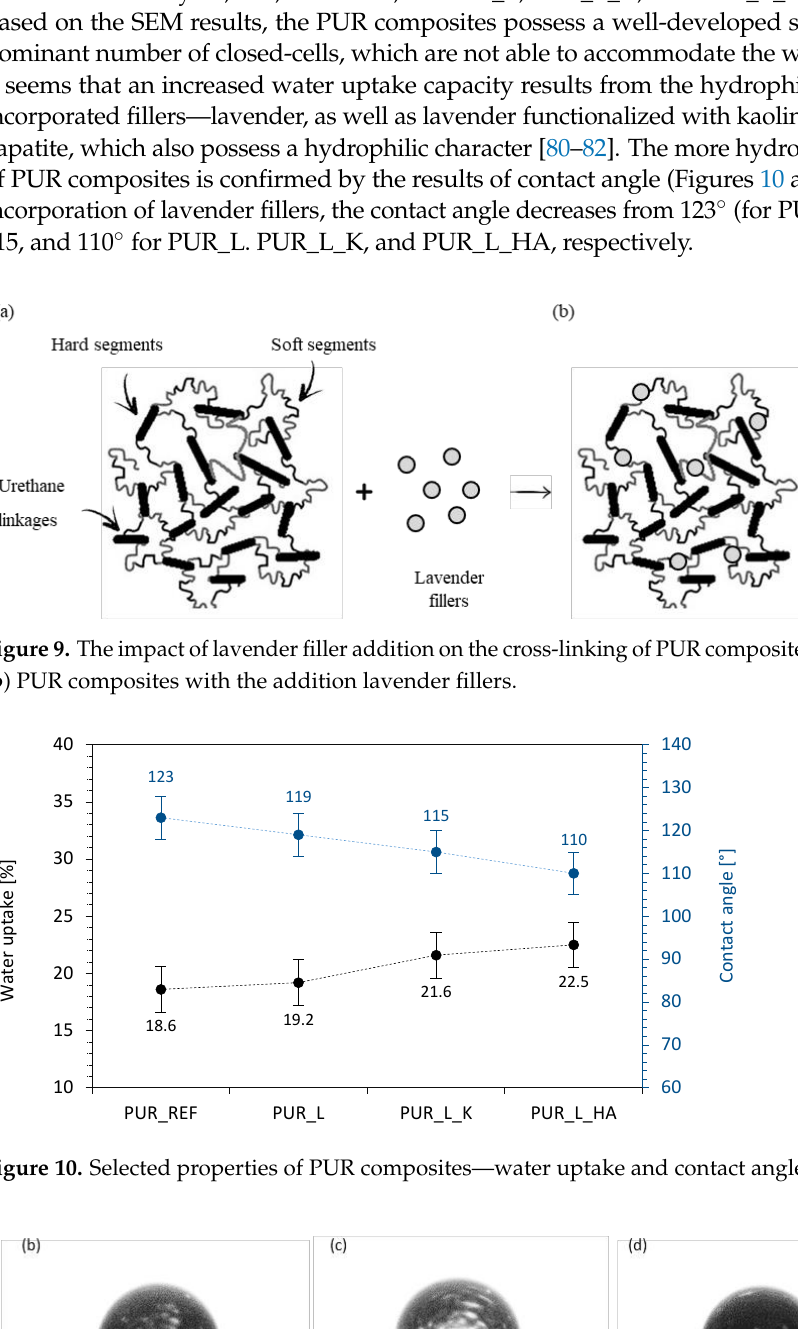
Table 5. Flame retardant properties of PUR composites.